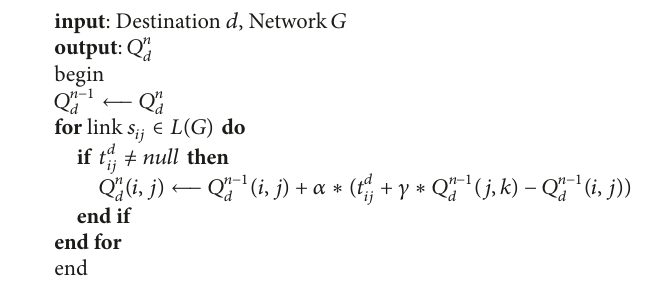
Algorithm 5: Procedure of Updating.